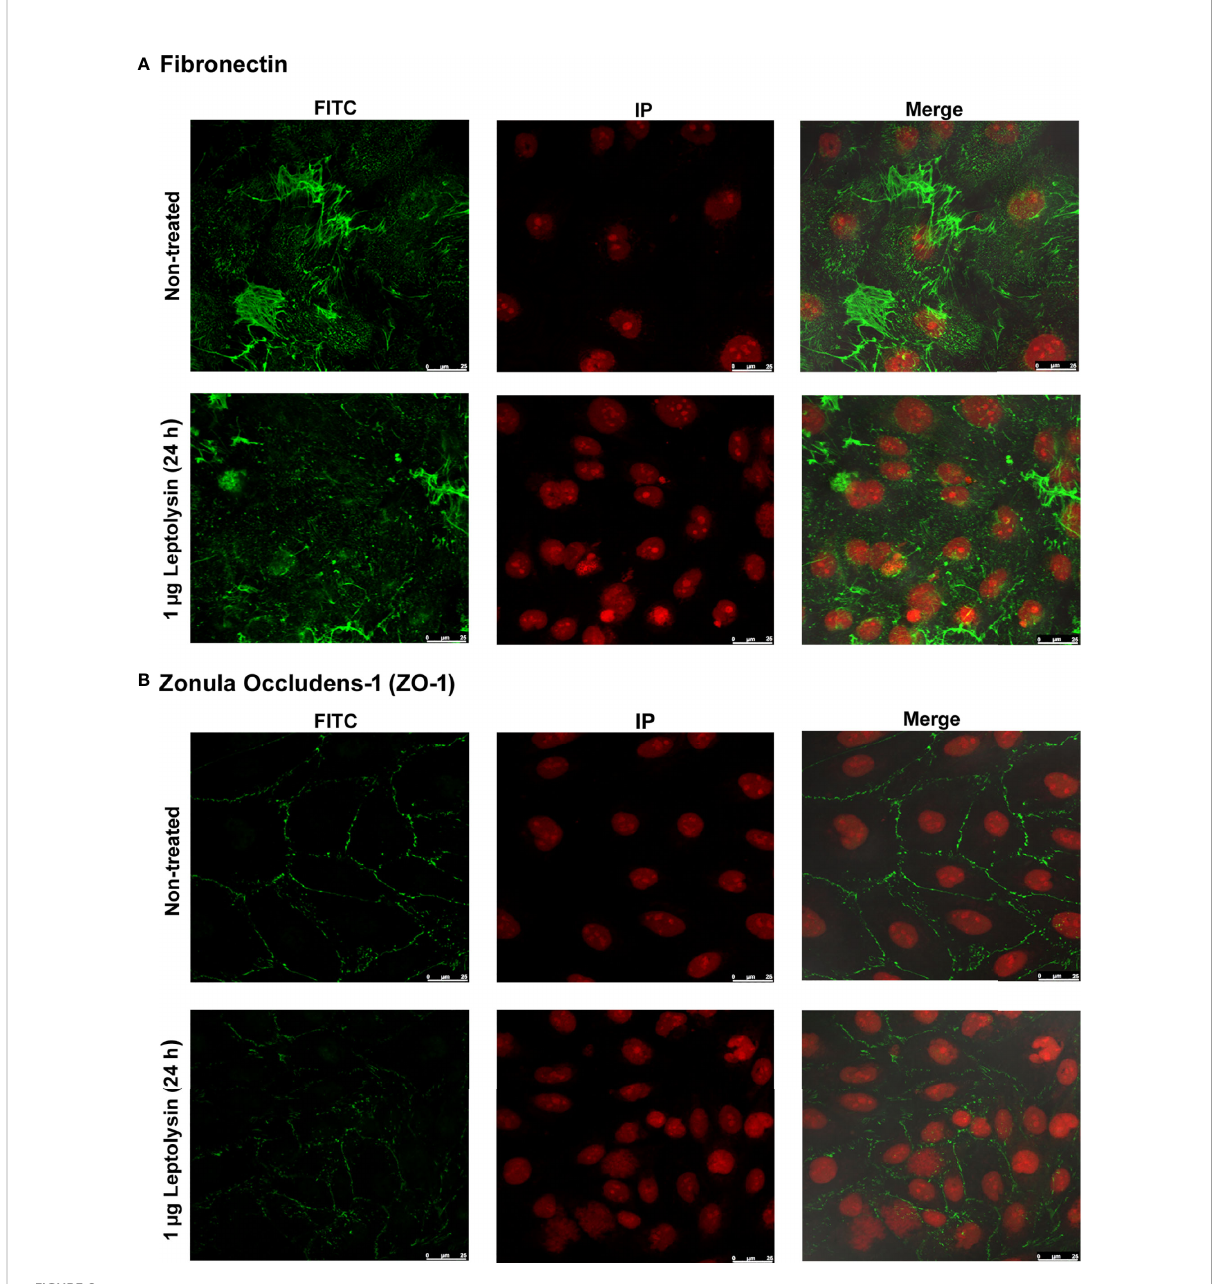
FIGURE 8 Effect of L. interrogans leptolysin on tight junction and ECM proteins in HK-2 cells detected by immuno fl uorescence microscopy. (A) Fibronectin and (B) Zonula occludens-1 (ZO-1) are shown in green. The nuclei are stained in red. Scale bars represent 25 m